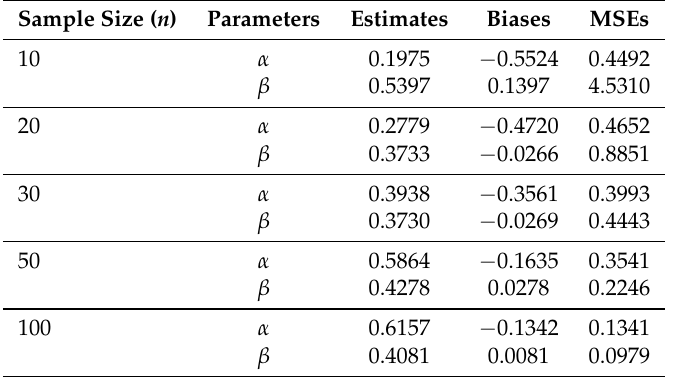
Table 2. Estimates, biases and mean squared errors (MSEs) for α = 0.75 and β = 0.4.